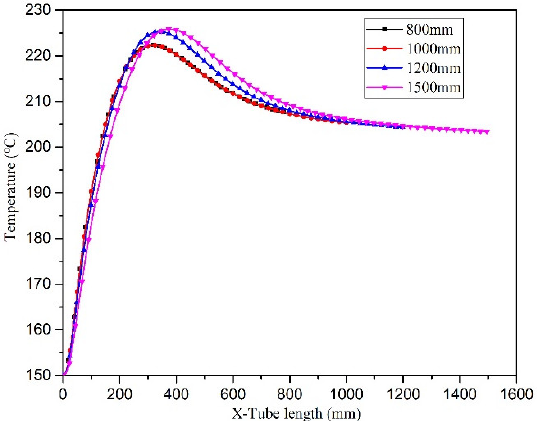
Figure 23. Temperature curve of the central axis of microreactors with different residence times.